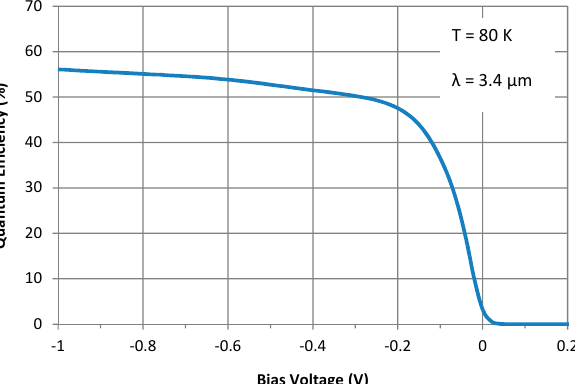
Figure 4. Variation of the external quantum efficiency (no AR coating) of the detector with bias at 80 K and 3.4 µm.